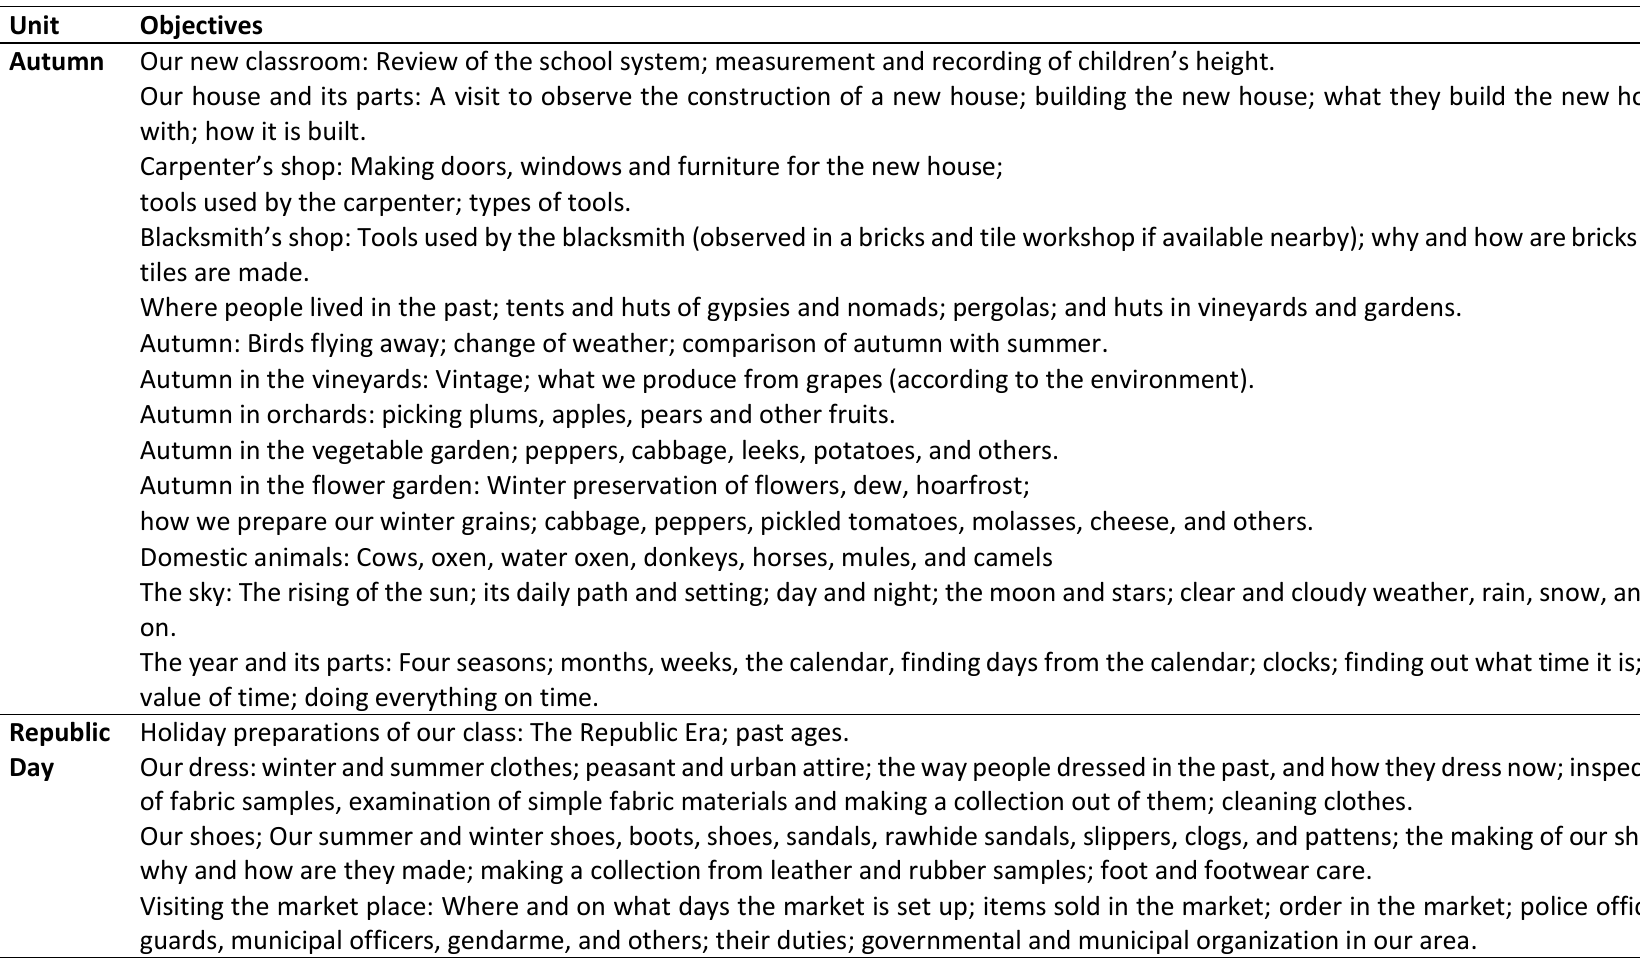
Table 4. Life Studies Curriculum Objectives in the Second Grade